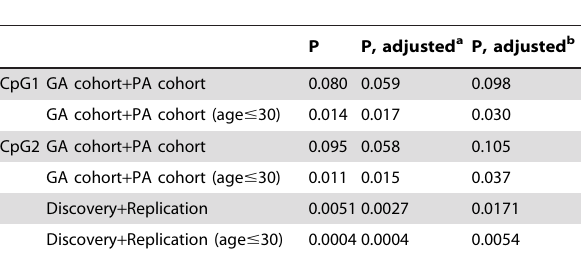
Table 7. Meta -analysis on two CpG sites in the SULF1